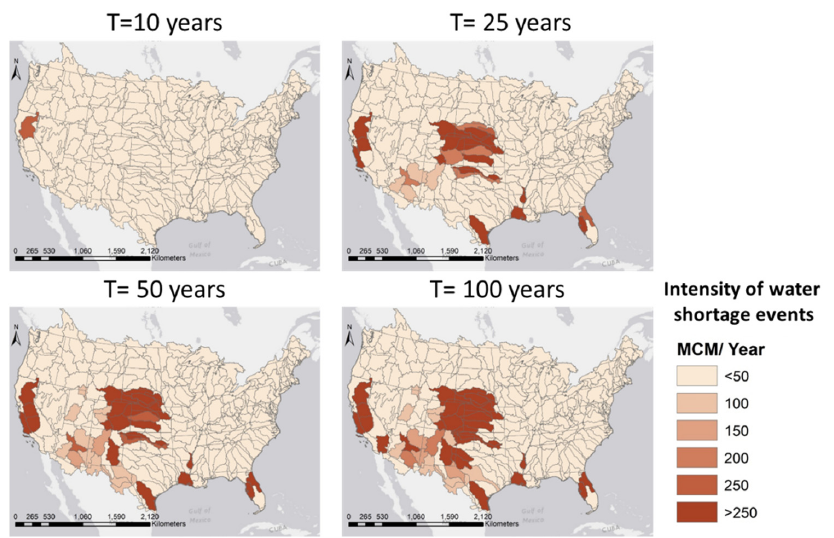
Figure 2. The intensity of water shortage events under the current conditions and at annual scale.